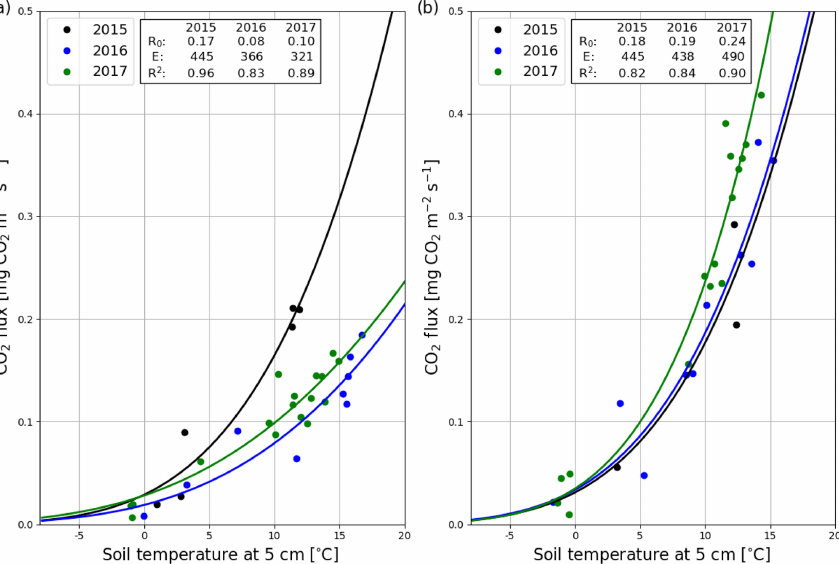
Figure 10. Temperature response (Eq. A3) of the hourly mean CO 2 fluxes measured with manual chambers at the clear-cut (a) and control (b) site in 2015 (black), 2016 (blue) and 2017 (green).